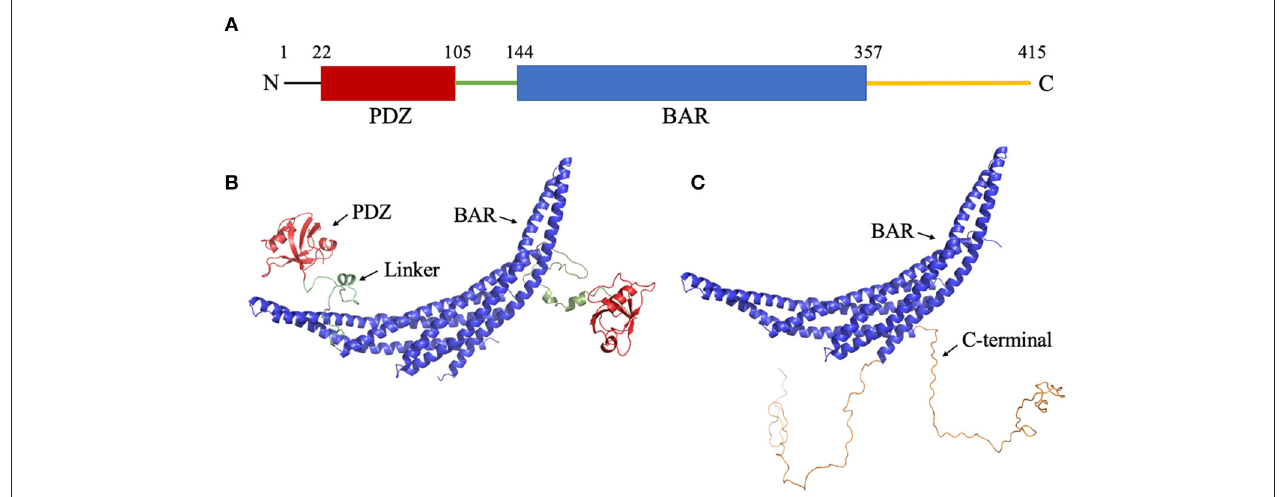
FIGURE 1 | Structure of PICK1. (A) Sequence of PICK1. Monomeric PICK1 is comprised of two modular domains, PDZ (red) and BAR (blue), and three intrinsically disordered regions, N-terminal, linker (green), and C-terminal (yellow). (B) Structure of PICK1 in the absence of N- and C-termini. (C) Dimeric BAR domain and intrinsically disordered